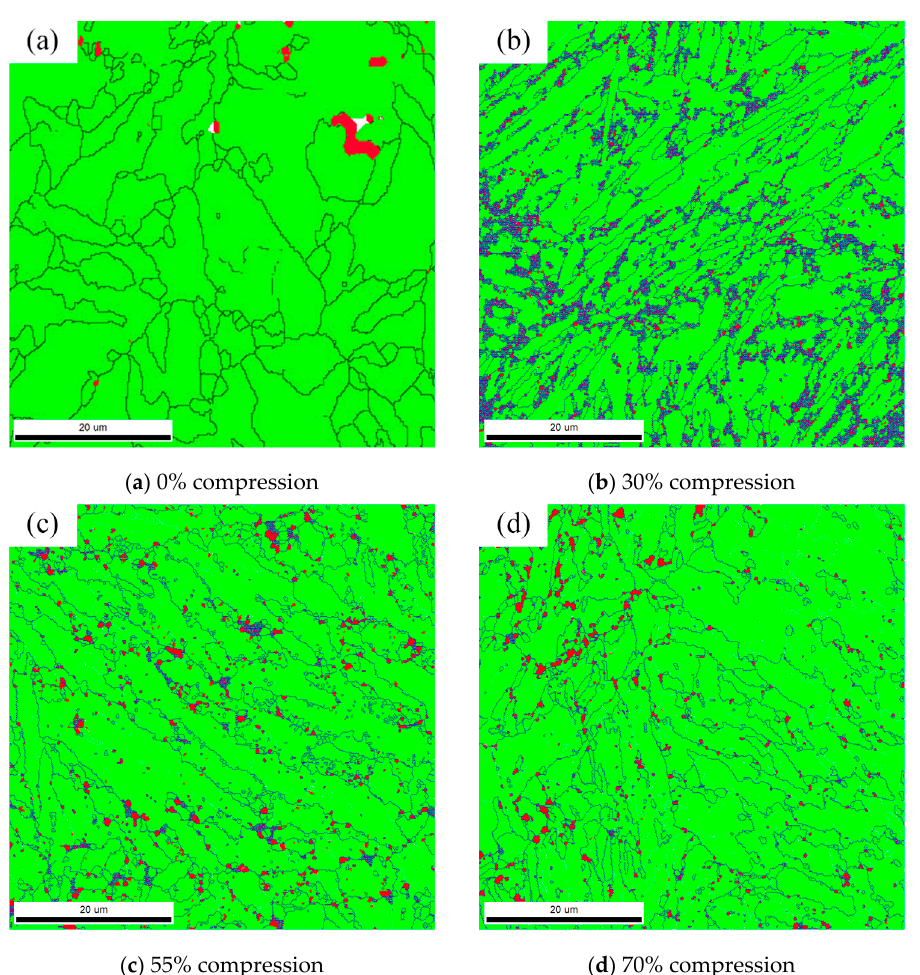
Figure 6. Retained austenite distributions in the specimens with different degrees of deformation.